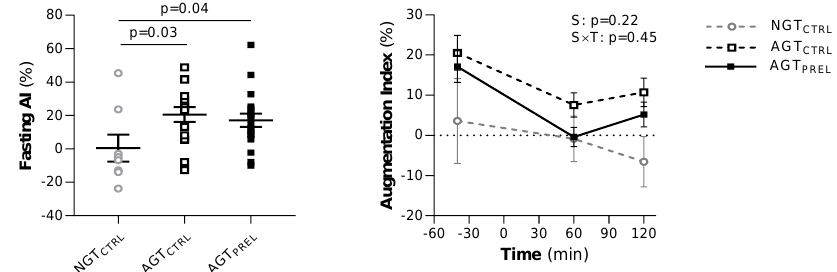
Figure 5. Fasting arterial stiffness assessed by the augmentation index (AI) and its change during two 75 g oral glucose tolerance tests preceded by water (CTRL) or a protein/lipid preload (PREL) in subjects with normal glucose tolerance (NGT) or abnormal glucose tolerance (AGT). Data are mean ± SEM. Baseline differences between the three groups were tested by Kruskal – Wallis test followed by post-hoc pairwise comparisons. In AGT, repeated measures were analyzed by mixed models including study (S), time (T), and an interaction term (S × T) as fixed effects and subject as random effect. p value for time effect is <0.05.